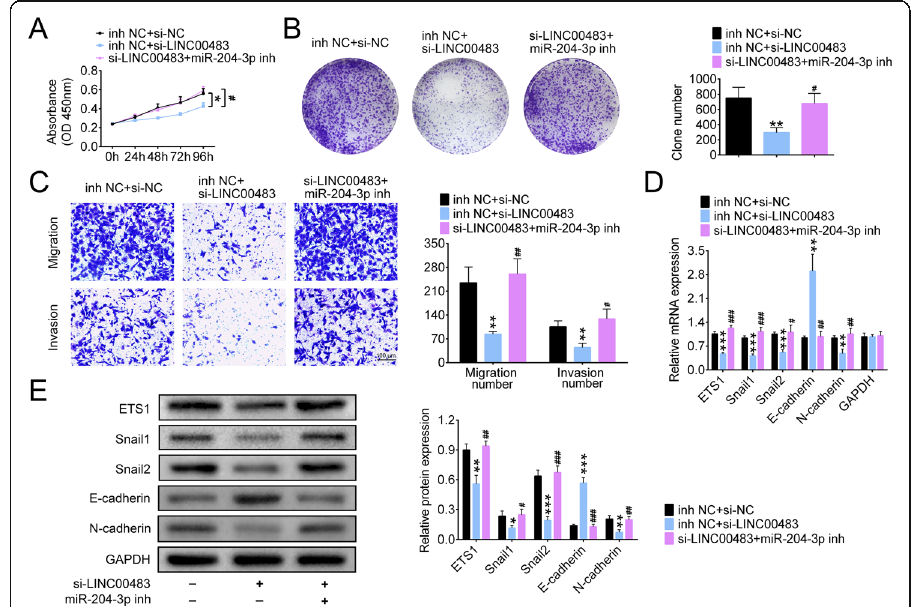
formation ( b ) assays. c The migration and invasion of A549 cells after LINC00483 silencing and miR-204-3p inhibition were assessed using a transwell assay. d and e The mRNA and protein levels of ETS1, Snail1, Snail2, E-cadherin and N-cadherin in A549 cells were measured using real-time PCR and western blotting, * p < 0.05; * # p < 0.05; ** p < 0.01; ## p < 0.01; *** p < 0.001; ### p <